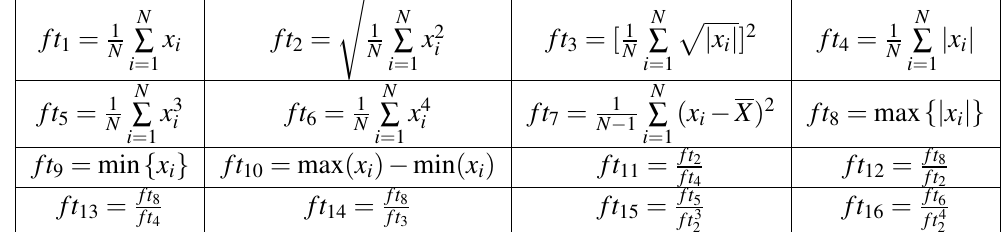
Table 1 Time-domain statistical characteristics.